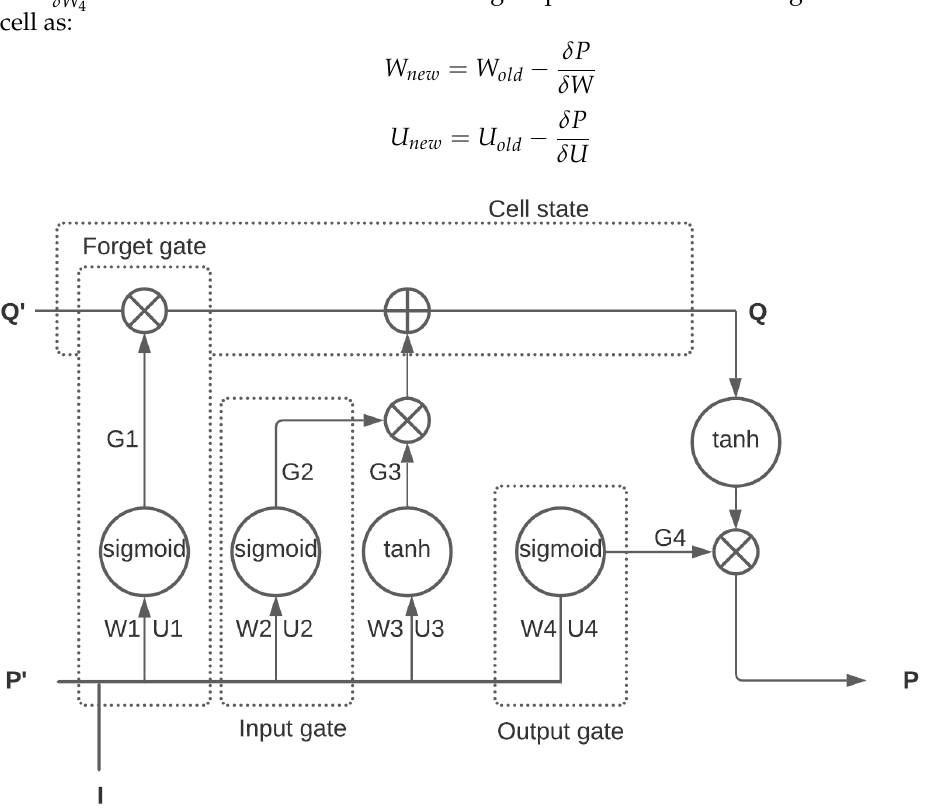
Figure 3. Architecture of the LSTM model (adapted from